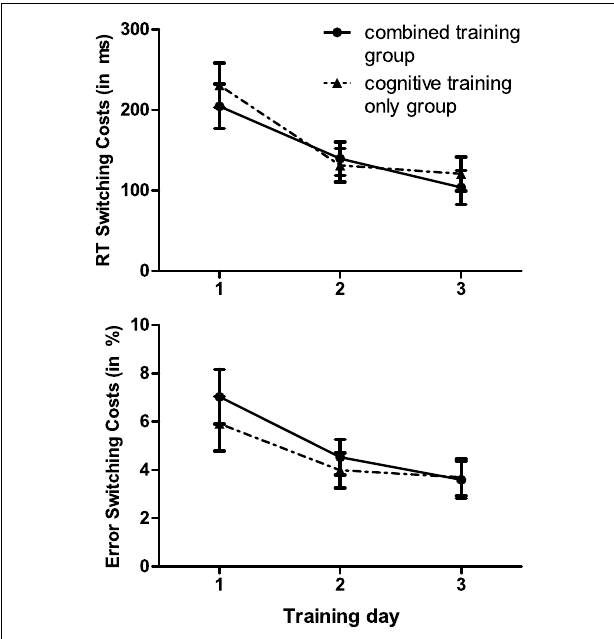
FIGURE 1 |Trajectories of RT switching costs (mean switching costs in ms ± SE) and error rate switching costs (mean switching costs in % ± SE) in the training task over the course of the three training days in the combined training group and the cognitive only training group.